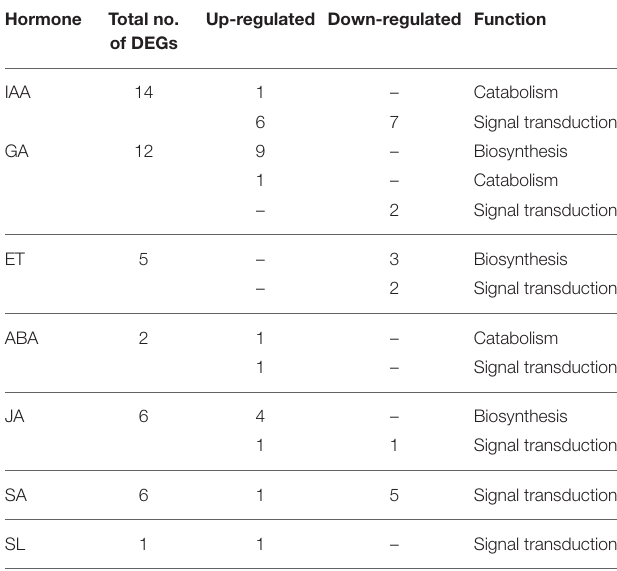
TABLE 5 | Differential expression patterns of plant hormone metabolism and signaling-related genes in comparison of libraries PAB vs. PNAB. Hormone Total no. of